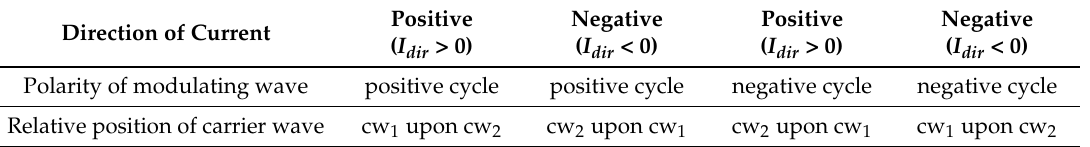
Table 1. Modulation strategy of improved PD ‐ PWM if V dc 1 > V dc2 .